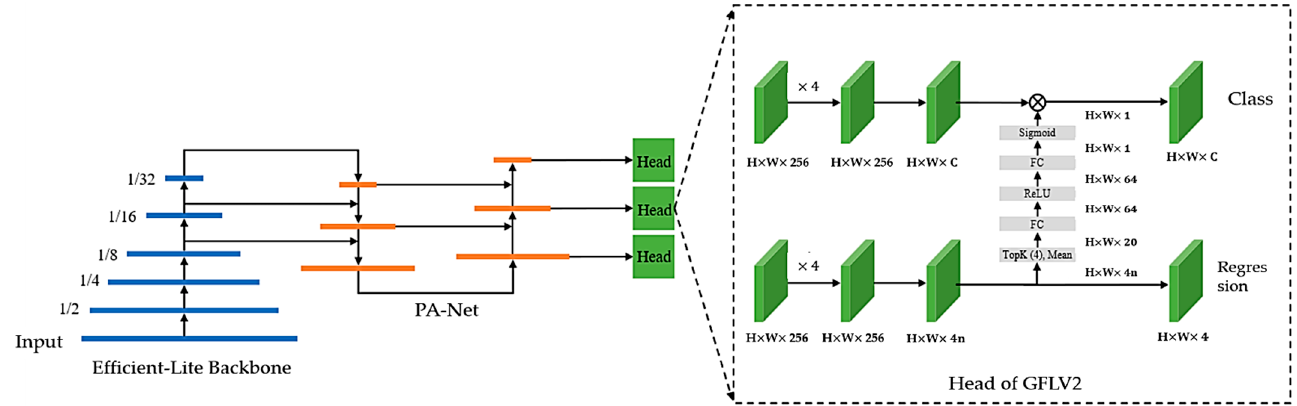
Figure 2. Proposed object detection architecture. The main components are the backbone architecture, which is based on the Efficient-Lite model [31], and a modified path aggregation network (PAN) [20] using Generalized focal loss v2 [32]as the detection head representation and loss function.